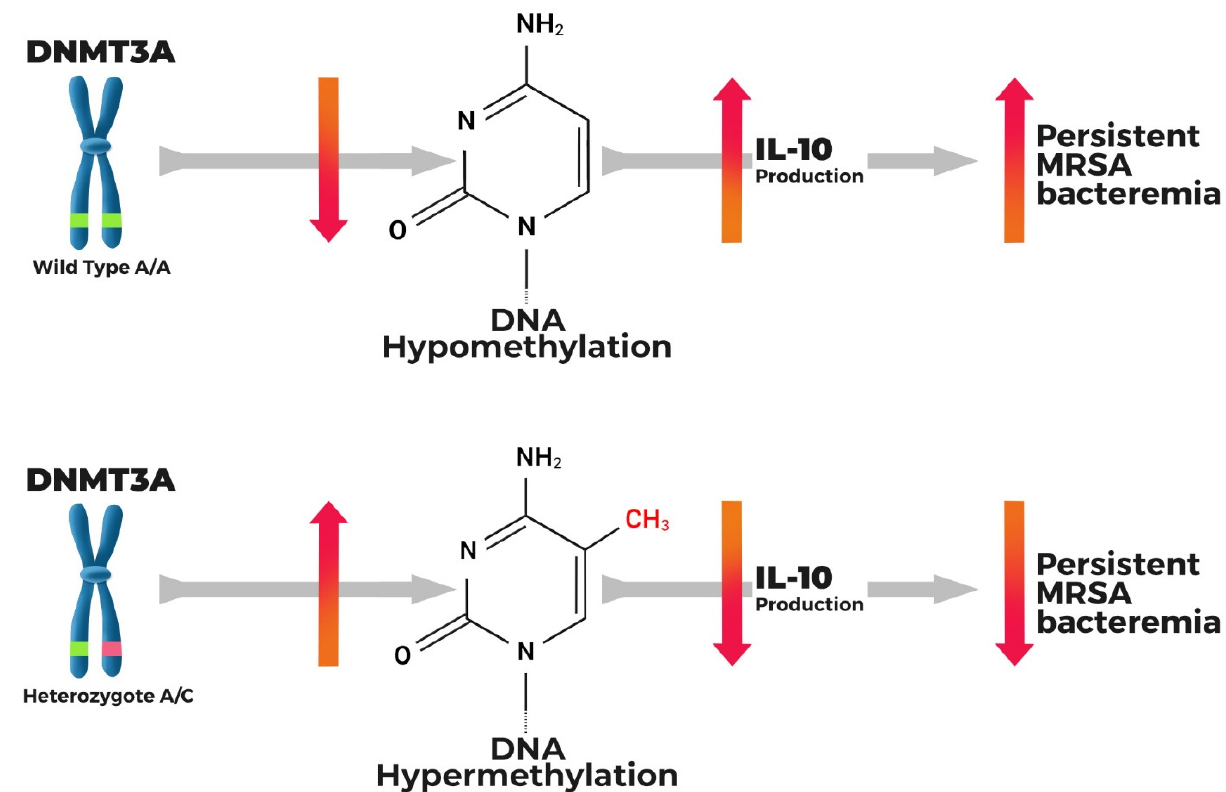
Figure 1. Proposed relationship of DNMT3A polymorphisms and increased risk of persistent MRSAB. Created using Biorender.com.